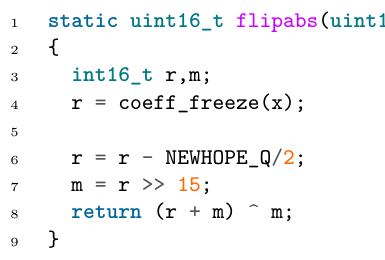
Figure 6: C source for the flipabs function of NewHope’s reference implementation. This function computes | ( x mod q ) − q